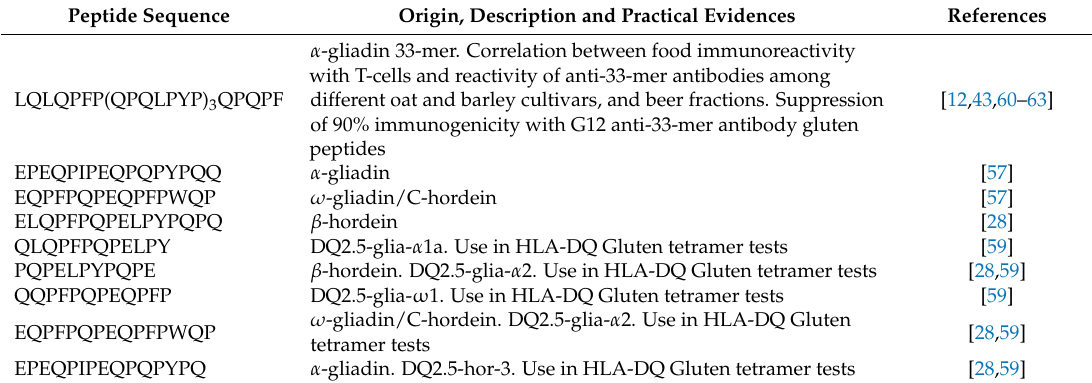
Table 1. Most relevant Gluten Immunogenic Peptides